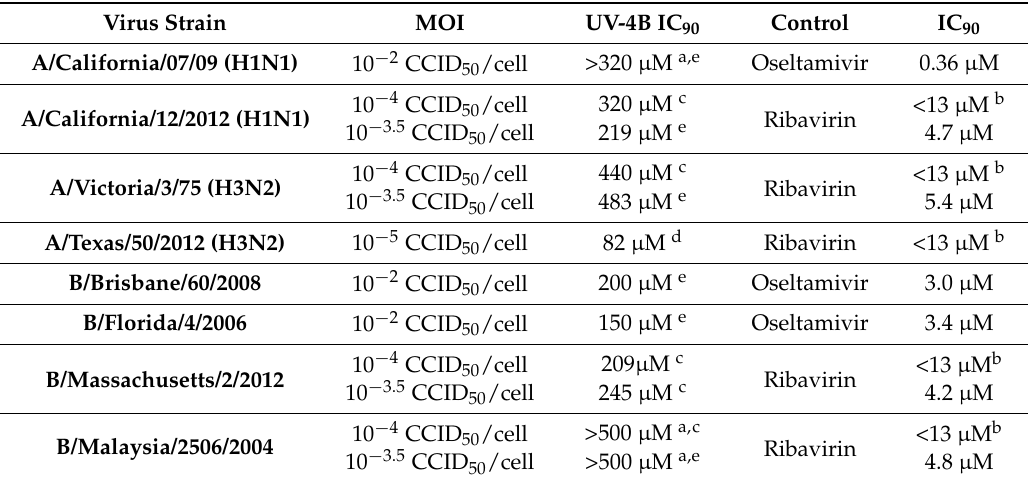
Table 1. Summary of UV-4B activity against multiple influenza strains in Differentiated Normal Human Bronchial Epithelial (dNHBE) cells